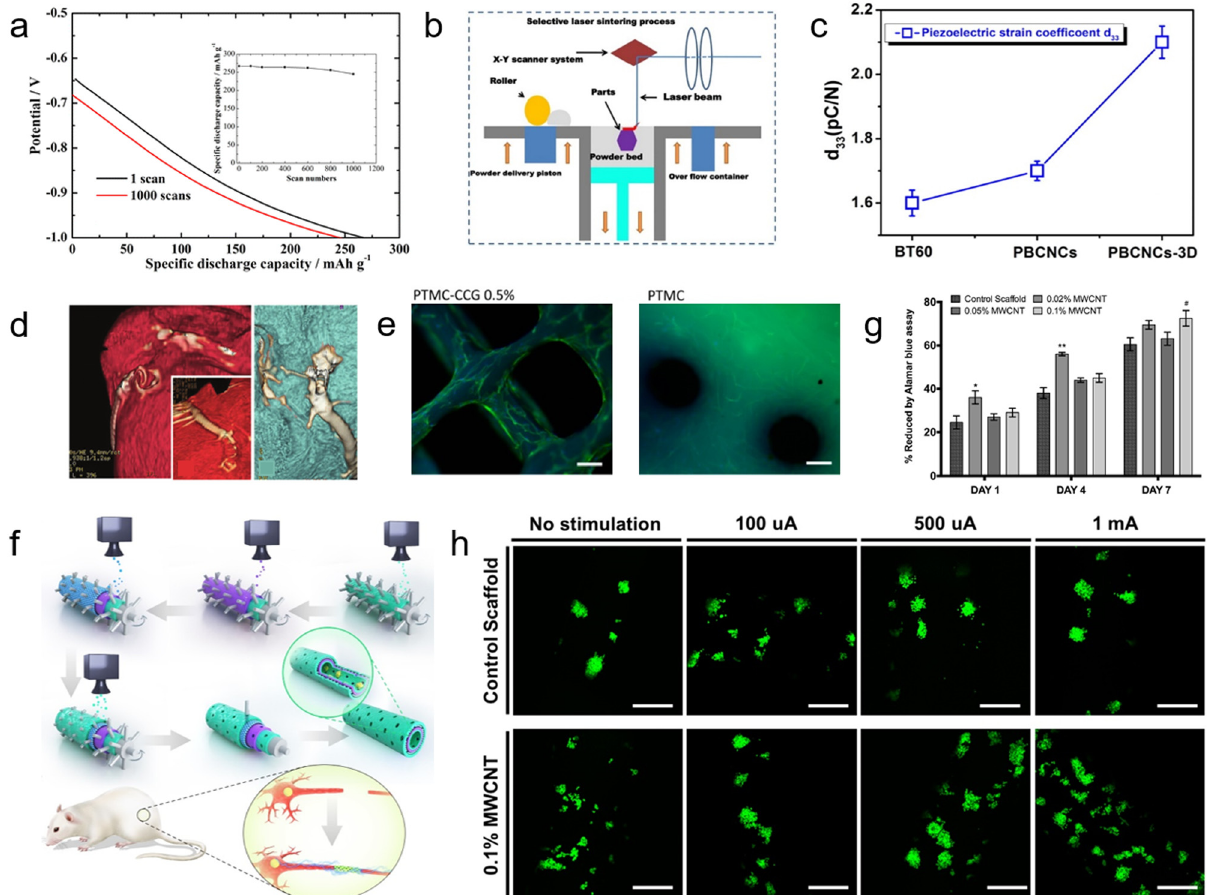
Figure 5: ( a ) Chronopotentiometric curves for 3D printed graphene pyramids with 5.0 mm height under speci fi c current of 40 mA/g, potential ranging − 0.5 to − 1.0 V and scan numbers 1 and 1,000. Speci fi c discharge capacity of the same sample as a function with scan numbers as inset. Reproduced with permission from ref. [ 79 ] , Copyright 2017 Springer. ( b ) Schematic of the SLS process. ( c ) Piezoelectric strain coe ffi cient d33 of the BT60, PBCNCs, and PBCNCs - 3D. Reproduced with permission from ref. [ 80 ] , Copyright 2018 Elsevier. ( d ) Computed tomographic scanning of pig heart with deployed 3D - printed PCL - GR stent. Reproduced with permission from ref. [ 84 ] , Copyright 2017 Wiley - VCH. ( e ) Actin cytoskeleton ( phalloidin ) staining of mesenchymal stem cells ( MSCs ) on 3D printed PTMC – CCG 0.5% and PTMC sca ff olds after 3 days of culture in maintenance medium. Scale bars represent 200 μ m. Reproduced with permission from ref. [ 87 ] , Copy - right 2016 American Chemical Society. ( f ) Schematic of graphene nerve conduit fabrication with layer - by - layer casting ( LBLC ) method. Reproduced with permission from ref. [ 88 ] , Copyright 2018 Nature Publishing Group. ( g ) Enhanced neural stem cell proliferation in 3D printed sca ff olds with or without MWCNTs after 7 days of culture. ( h ) Fluorescent micrographs of green fl uorescent protein ( GFP )- transduced neural stem cells ( NSCs ) with di ff erent electrical stimulation parameters after 4 day of culture. Scale bar = 100 μ m. Reproduced with permission from ref. [ 90 ] , Copyright 2018 IOP Publishing